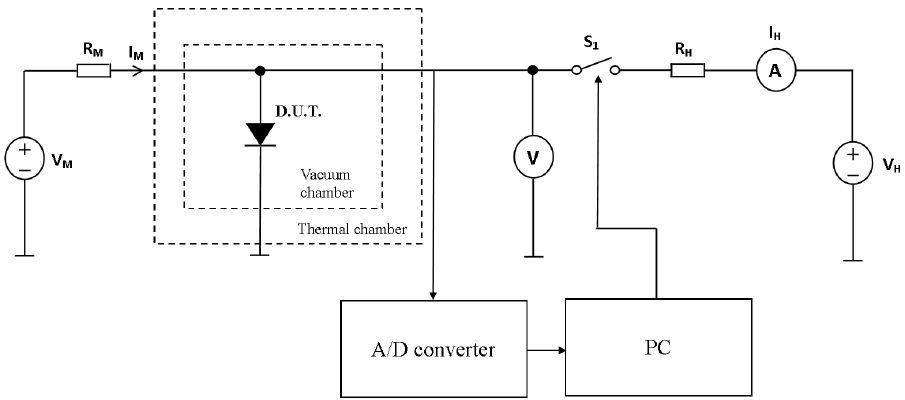
Figure 2. Diagram of the measurement set-up to measure transient thermal impedance of a diode.